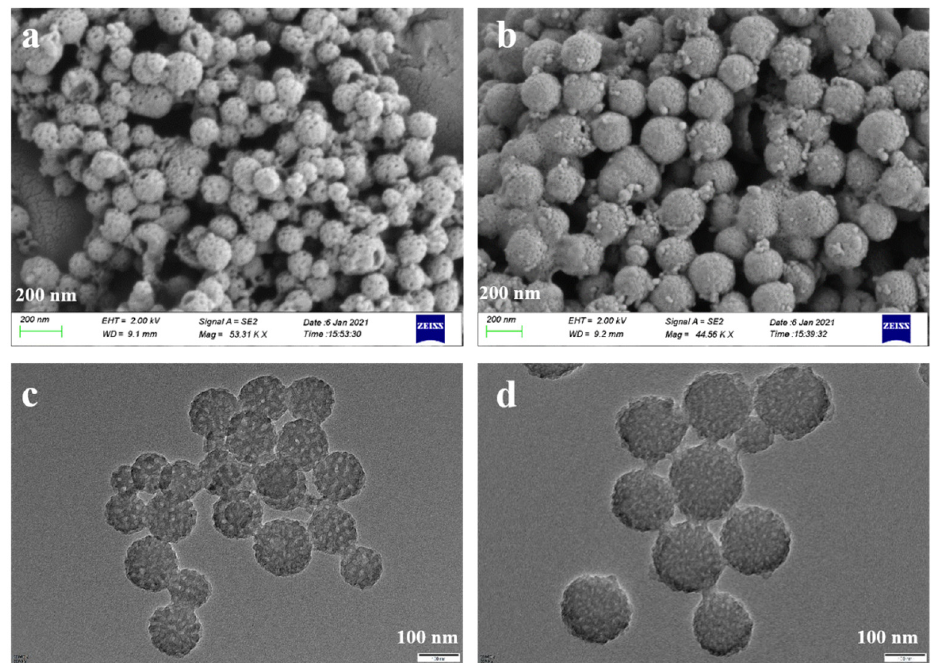
Figure 3. SEM images of ( a ) MPDA and ( b ) MPDA-DOX@FU-SS. TEM images of ( c ) MPDA and ( d ) MPDA-DOX@FU-SS.